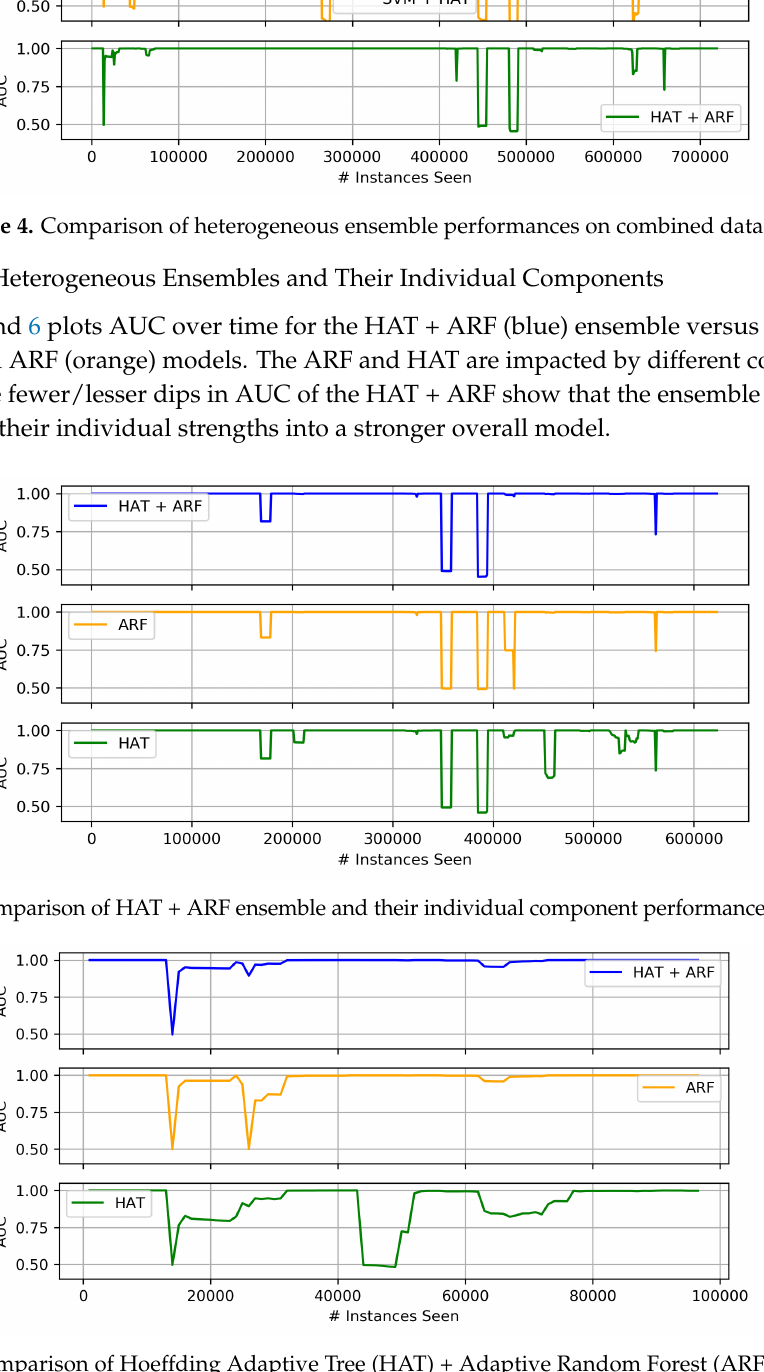
Figure 6. Comparison of Hoeffding Adaptive Tree (HAT) + Adaptive Random Forest (ARF) ensemble and their individual component performances on